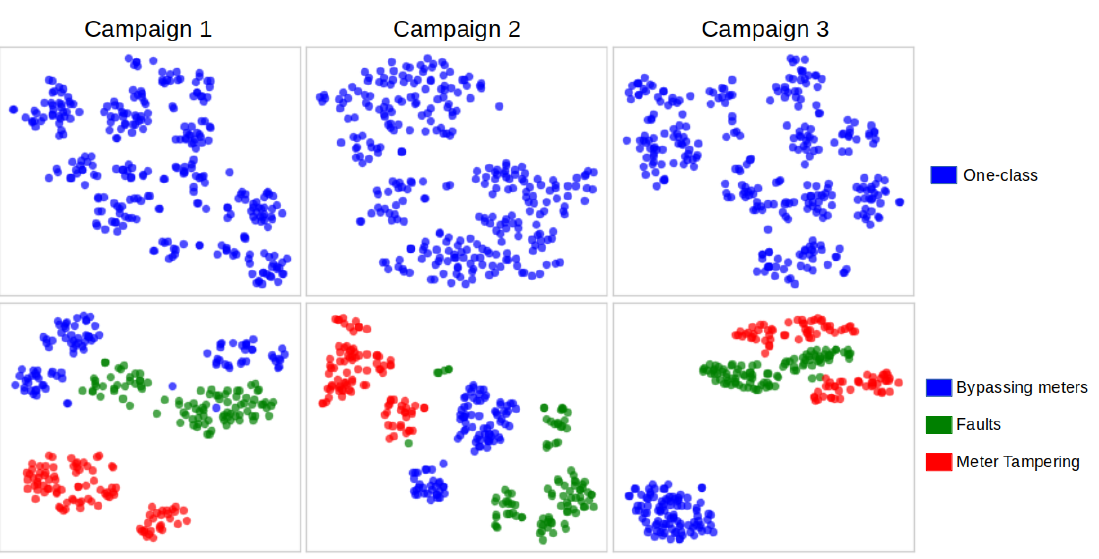
Figure 3. From left to right are represented the different campaigns. The upper representations are built using the baseline dataset: each dot represents the Shapley values for the prediction of a client. The bottom images also contain the Shapley values but coloring each profile according to the NTL